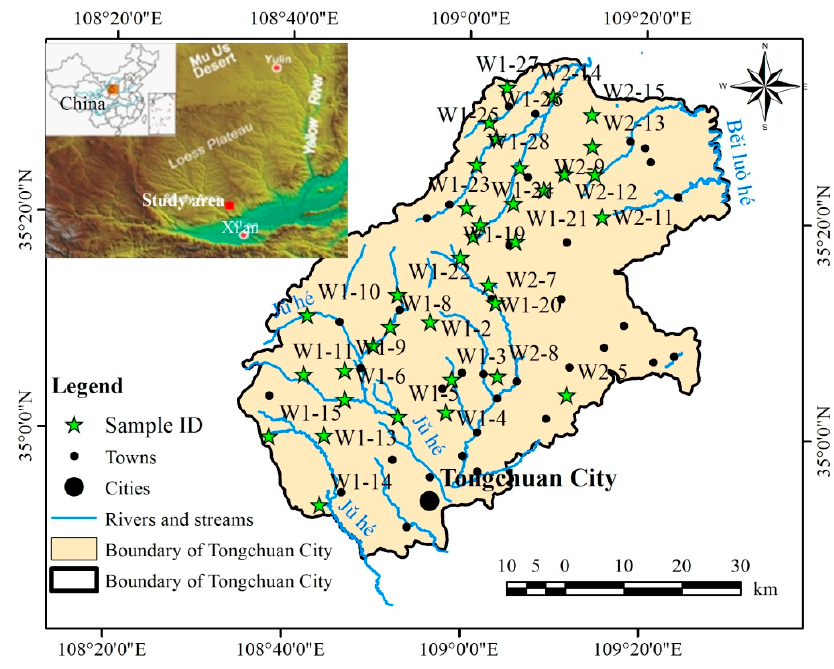
Figure 1. Study area and samples distribution.